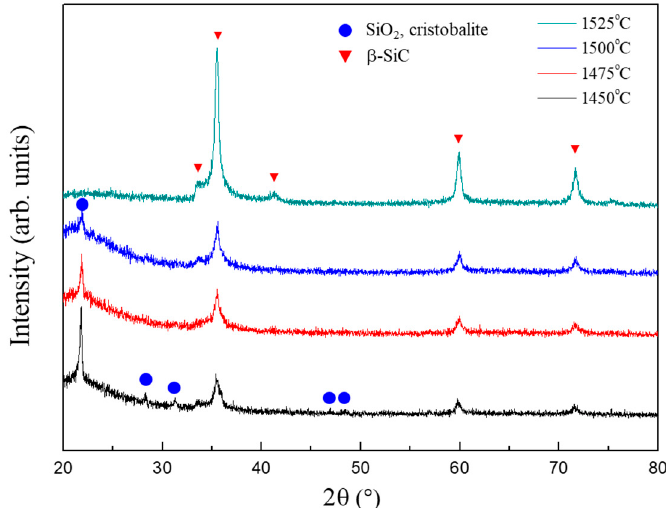
Figure 5. XRD patterns of the powder samples synthesized from the SiO 2 –C mixtures with the C/SiO 2 ratio of 0.5 at various reduction temperatures.